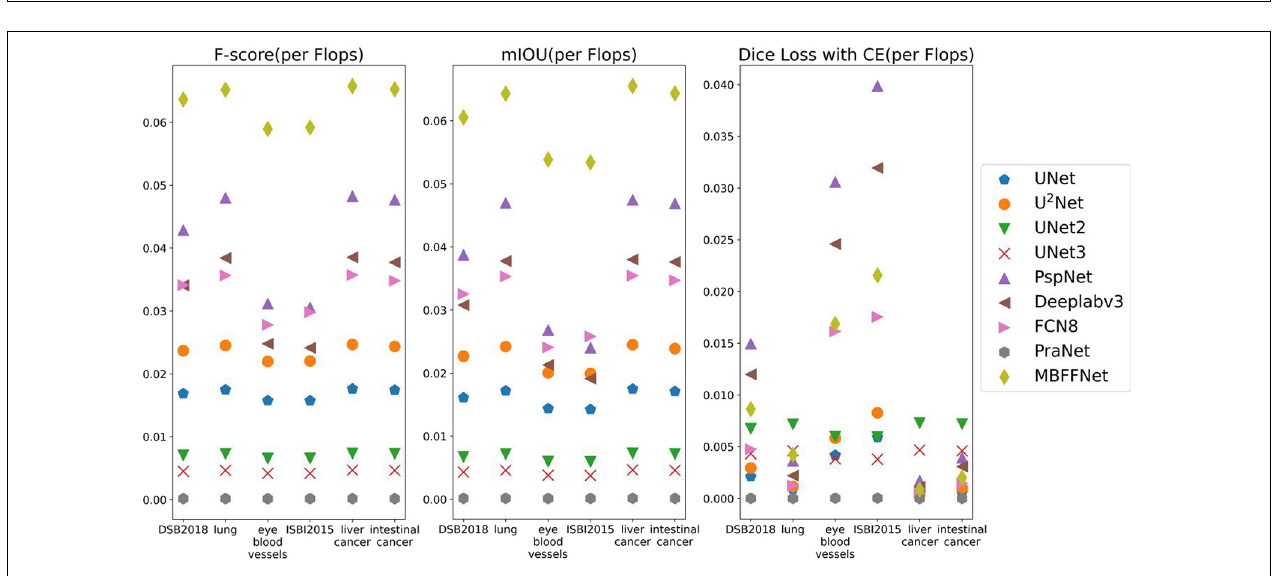
FIGURE 8 | Comparison between the accuracy of different models and Flop